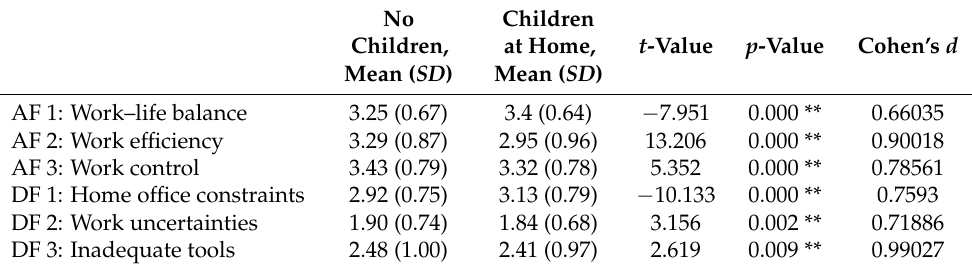
Table 5. Results of the t -test for the number of children <15 years at